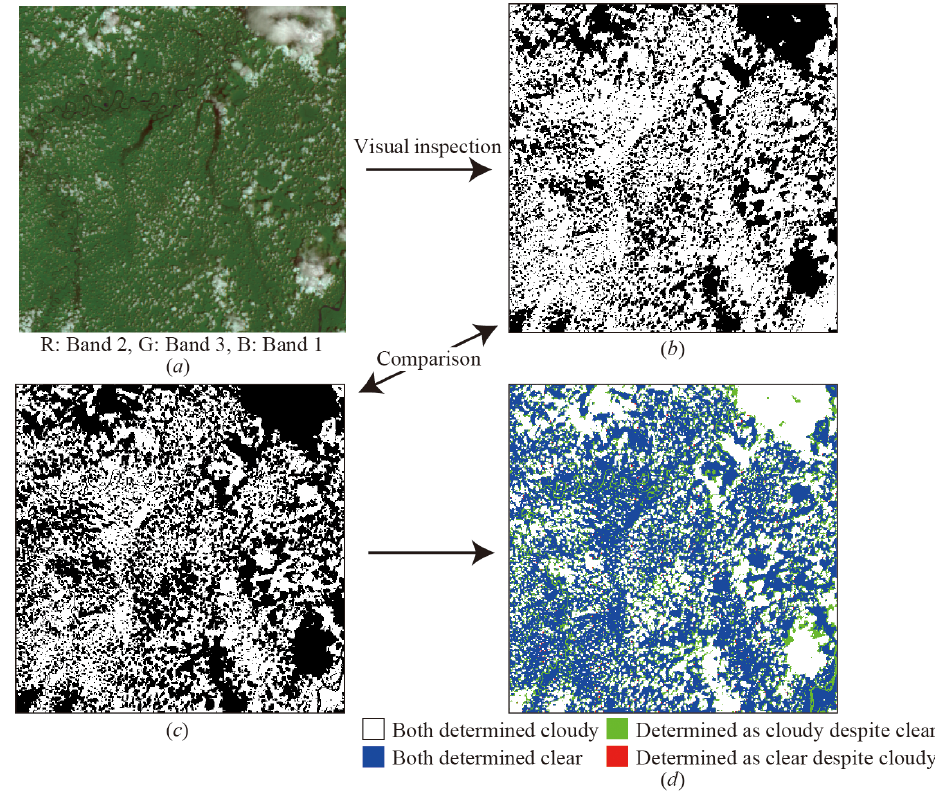
Figure 8. Analysis procedure. (a) CAI L1B image. (b) Visual inspection mask of CAI L1B. (c) Output mask from CLAUDIA1–CAI (CAI L2 cloud flag product) or CLAUDIA3–CAI. Pixels that are determined as cloudy are black. (d) Comparison of the visual inspection image and the output image. Pixels that are determined as cloudy in both are white. Pixels that are determined as clear in both are blue. Pixels that are determined as cloudy in the output image and clear in the visual inspection image are green. Unusual pixels that are determined as clear in the output image and cloudy in the visual inspection image are red. Table 4. Yearly average accuracy, overlook, and overestimate for various land cover types. Australia Japan Borneo